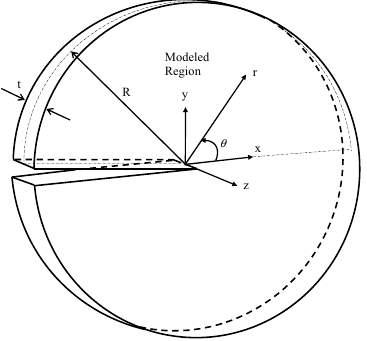
Figure 1. Three-dimensional (3D) modified boundary layer model.